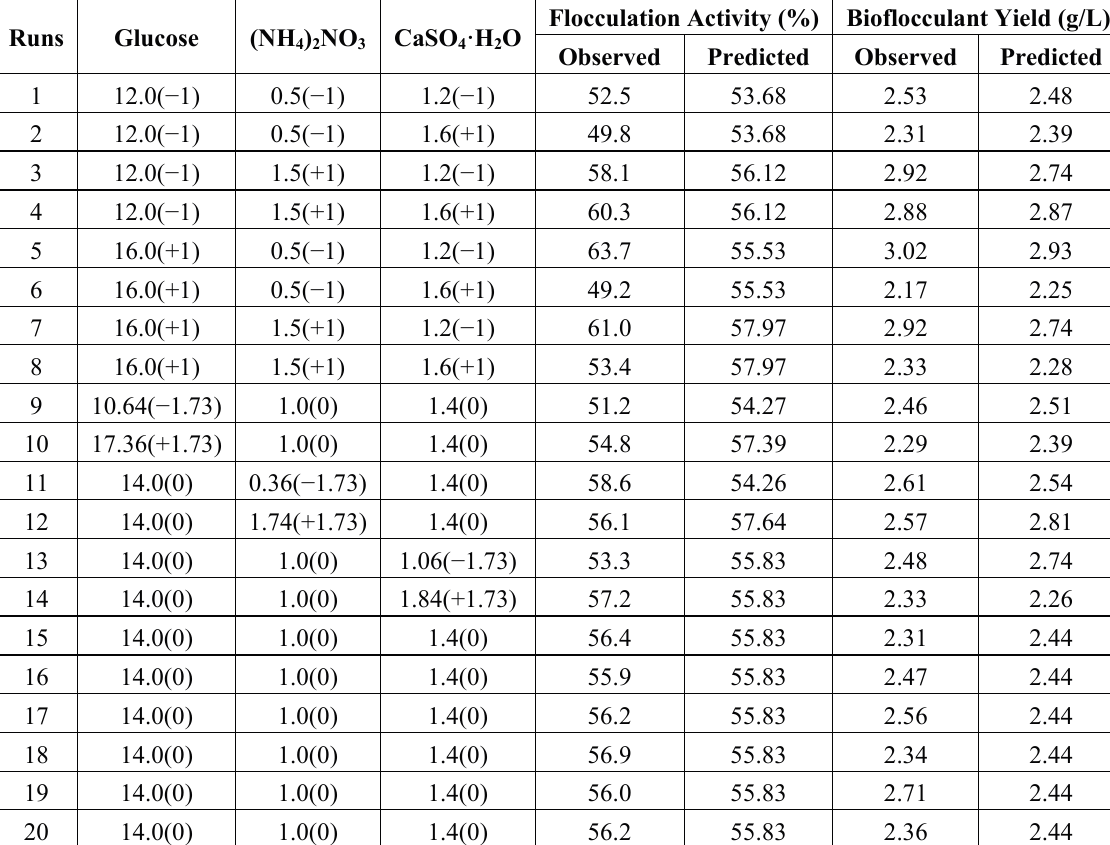
Table 4. Central composite design matrix for critical media components showing the observed and predicted values for flocculation activity and bioflocculant